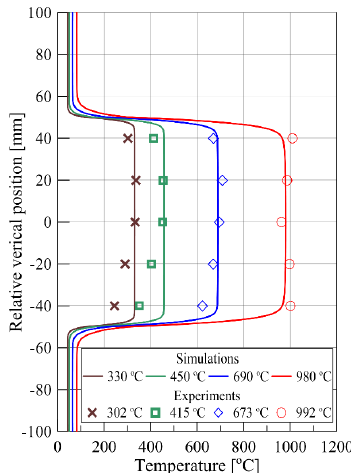
Figure 5. Comparison of the vertical temperature profiles of Tube 1-03 between the experimental measurements and numerical predictions.